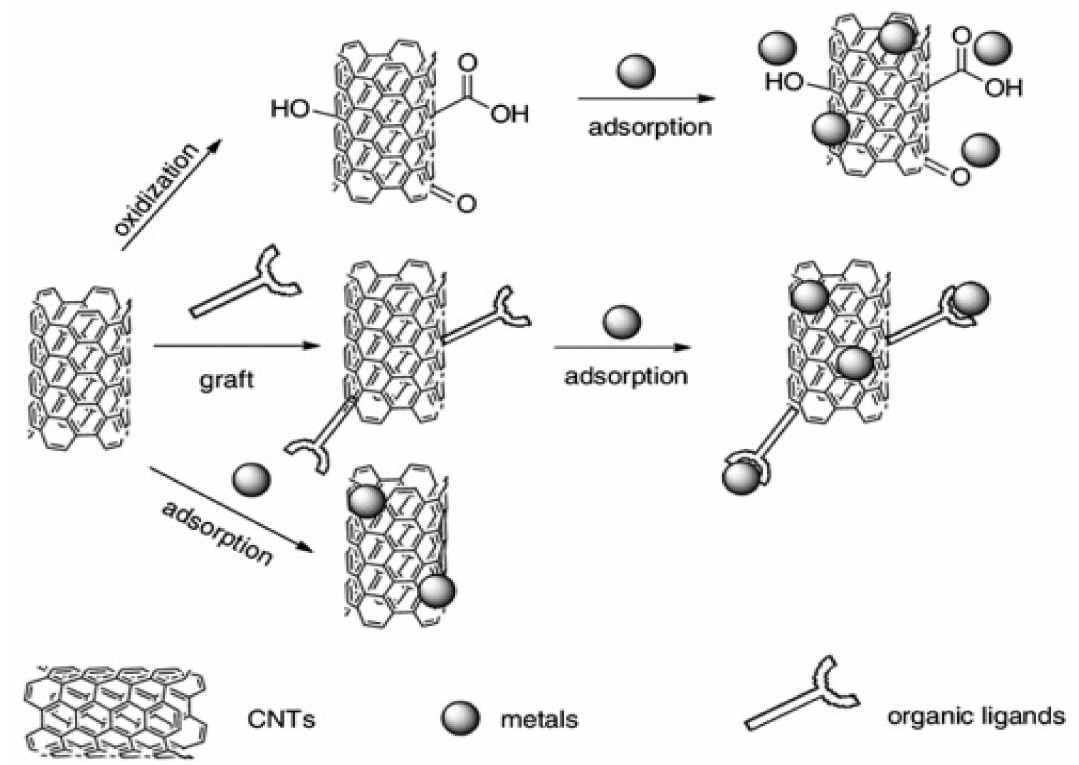
Figure 13. Schematic representation of CNTs grafting and metals adsorption [268].